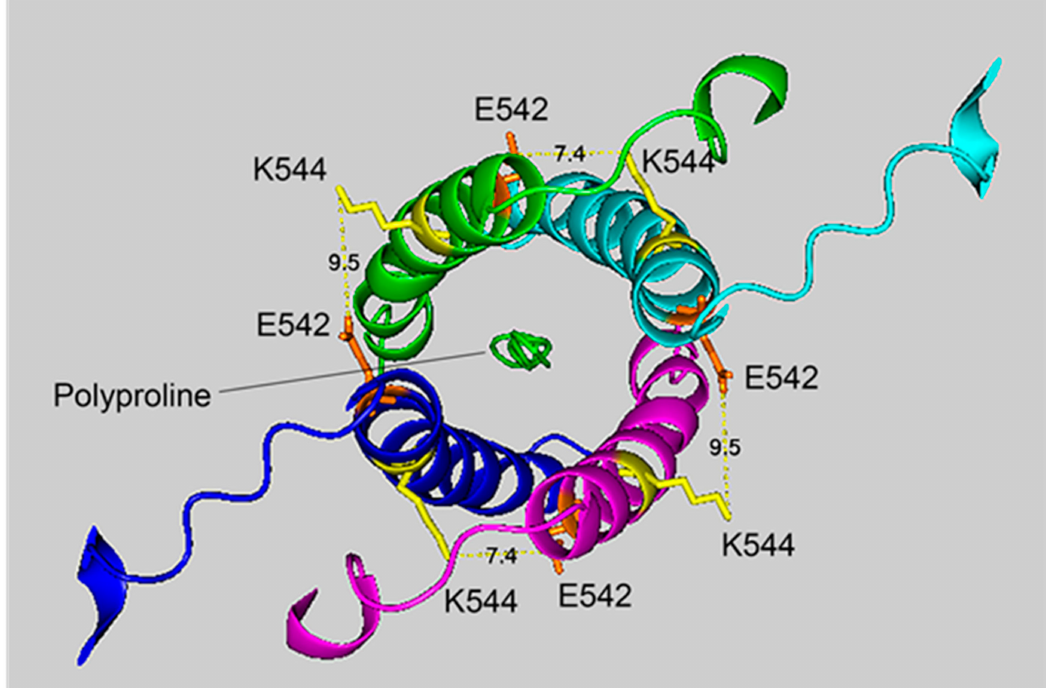
Figure 4. The crosslinking region of tetrameric HuBChE illustrating the location of the crosslinked residues for the peptide pair VLEMoxTGNIDEAEWEWK 544 AGFHR–VLEMoxTGNIDEAEWE 542 WK. The image shows the C-terminal α -helices from each monomer coiled into a superhelix, with a tetramer-forming polyproline II helix in the center. Lysines responsible for the crosslink are shown in yellow, while glutamates are orange. Potential bonds are indicated by dashed lines with the distance between residues given in Å. Deep-blue, purple, light blue and green identify α -helices from di ff erent HuBChE